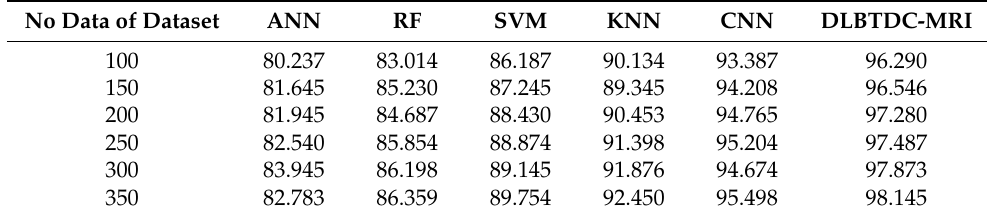
Table 3. F-Score analysis of DLBTDC-MRI method with existing system.